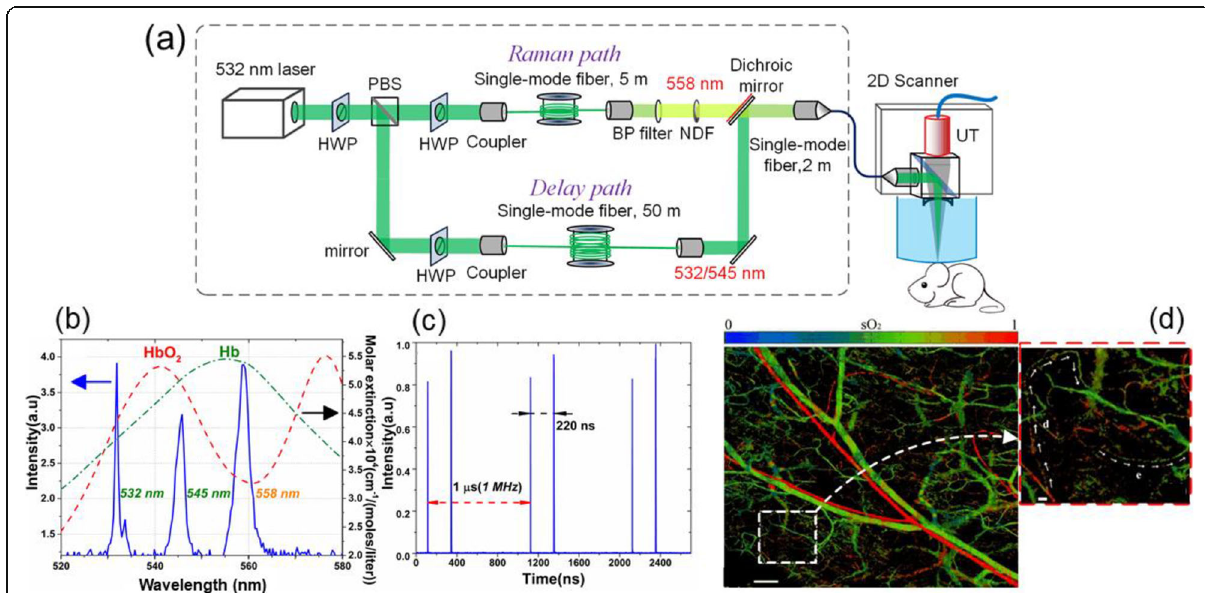
Fig. 5 SRS-based multiwavelength fiber laser source for functional PAM. ( a ): Schematic of the laser and PAM; ( b ): Laser output spectrum; ( c ): Temporal signal of the output laser; and ( d ): In vivo oxygen saturation imaging result. Scale bar: 200 μ m. Closeup shows the variation in oxygen saturation in single capillaries [34]